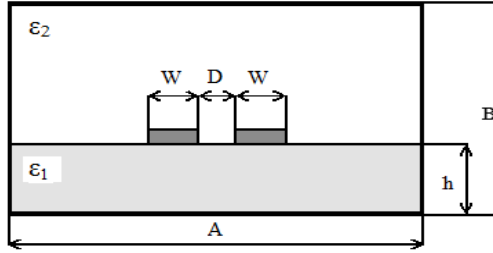
Fig. 7. Design cross-sectional SSL (strips 1 and 2).